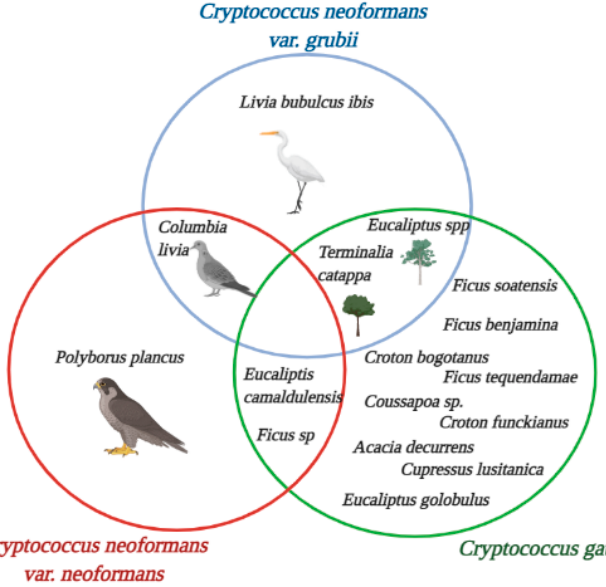
Figure 2. Environmental isolate sources of C. neoformans and C. gattii species complexes in Colombia. Source: The authors of this study; image created in BioRender.com.